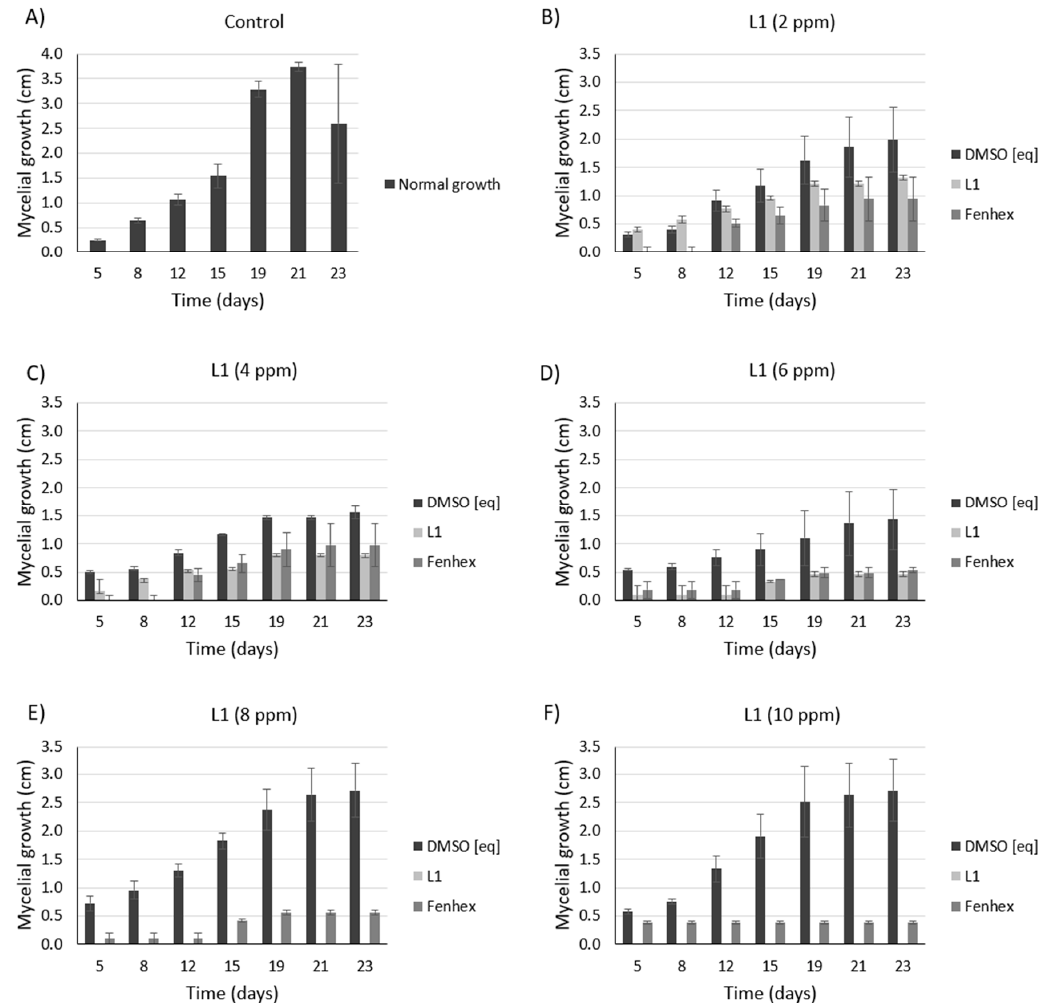
Figure 6. Antifungal effect against Botrytis cinerea B05.10 (at 26 °C) exerted by L1 in a dose-dependent manner. Inhibition of mycelial growth (by measuring the colony diameter) was observed in the presence of L1 (( A ): 0 ppm, ( B ): 2 ppm, ( C ): 4 ppm, ( D ): 6 ppm, ( E ): 8 ppm, ( F ): 10 ppm) and compared with the commercial fungicide fenhexamid (( A ): 0 ppm, ( B ): 2 ppm, ( C ): 4 ppm, ( D ): 6 ppm, ( E ): 8 ppm, ( F ): 10 ppm). Since both L1 and fenhexamid stock were dissolved in DMSO (vehicle), DMSO alone was also tested, adding the same concentration used with either L1 or fenhexamid in each case (( A ): 0% v / v , ( B ): 0.015% v / v , ( C ): 0.030% v / v , ( D ): 0.045% v / v , ( E ): 0.060% v / v , ( F ): 0.075% v / v ) (DMSO [eq]). In all cases, the experiments were performed in biological triplicate.